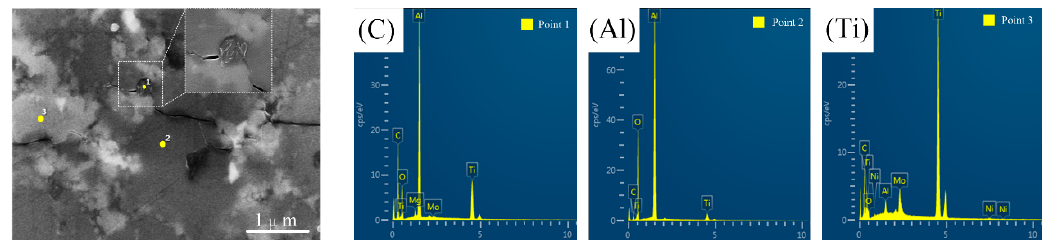
Figure 9. SEM morphology and element distribution of points 1, 2, and 3.